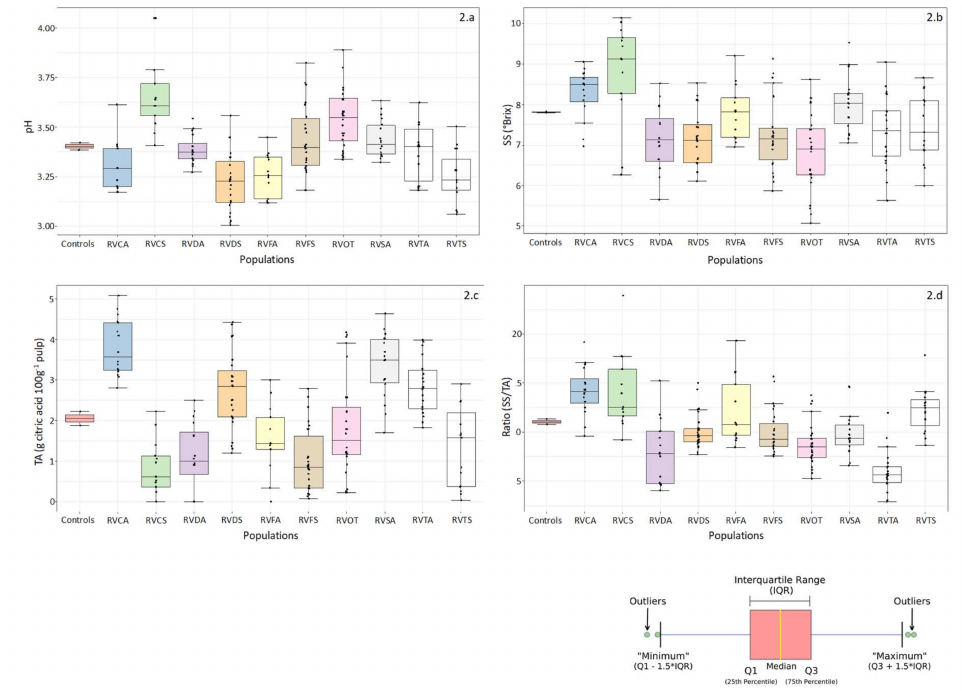
Figure 2. Boxplot analysis for ( a ) pH, ( b ) Soluble Solids (SS, Brix), ( c ) Titratable Acidity (TA, g citric acid 100g − 1 pulp), and( d )SS / TAratio: SolubleSolids /